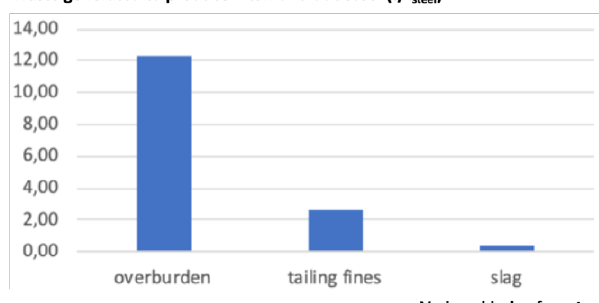
Figure 2. Waste generated in the production of 1 t of crude steel (source: author).